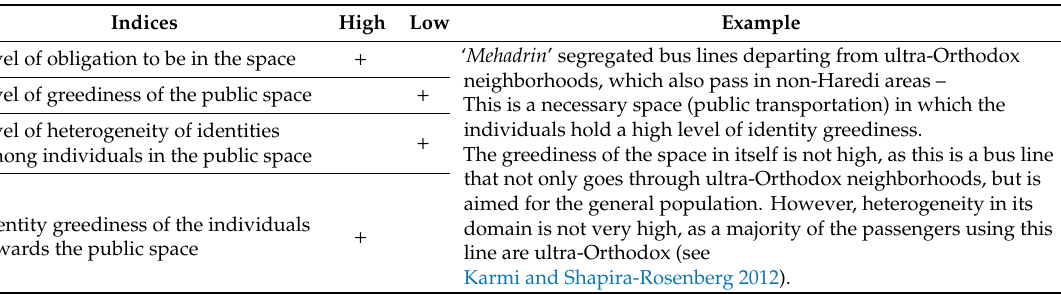
Table A16. Medium potential